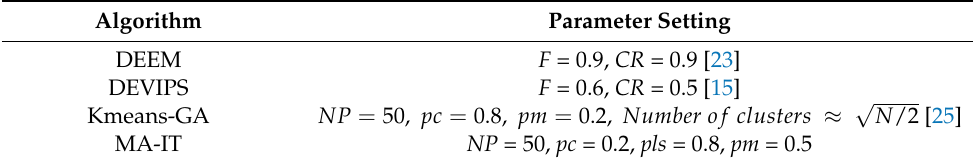
Table 1. Parameter settings of